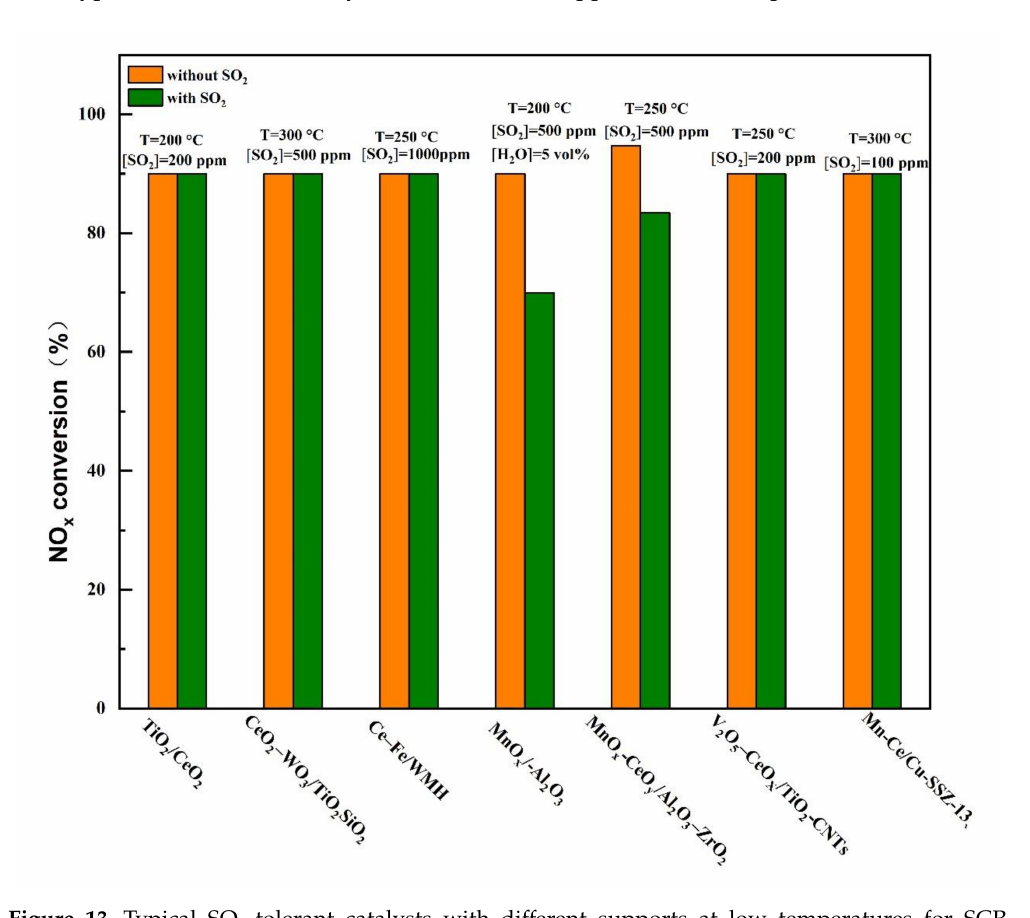
Figure 13. Typical SO 2 -tolerant catalysts with di ff erent supports at low temperatures for SCR reaction